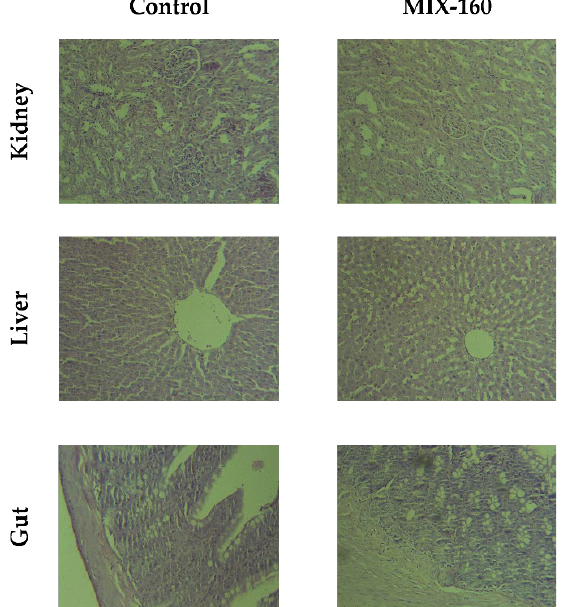
Figure 4. Histological evaluation of kidney, liver, and intestine tissues of the control vs. MIX–160 treated groups.